Question: Name the type of graph shown.
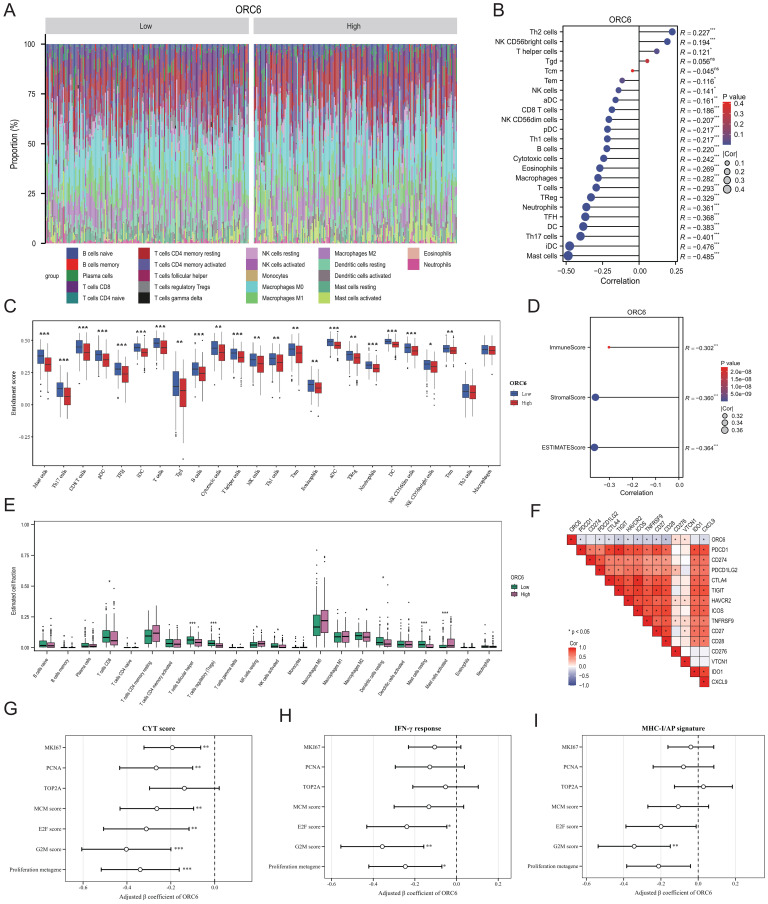
Answer: heatmap